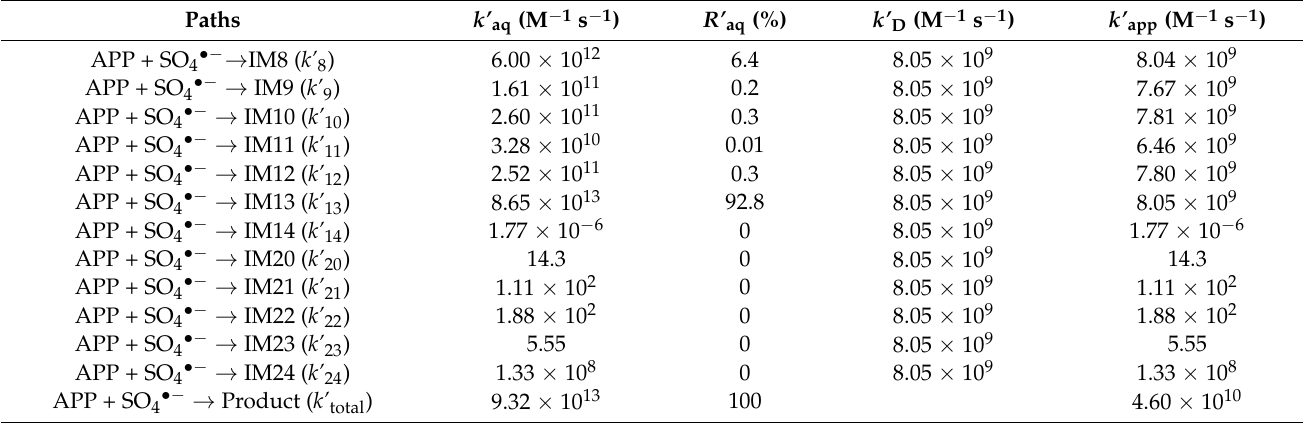
Table 3. The calculated rate constants( k’ aq ), steady-state rate constant ( k’ D ), apparent rate constant ( k’ app ) and branching ratio ( R’ aq ) for the AAP with SO 4 •− reaction in the aqueous phase at 298 K. Paths